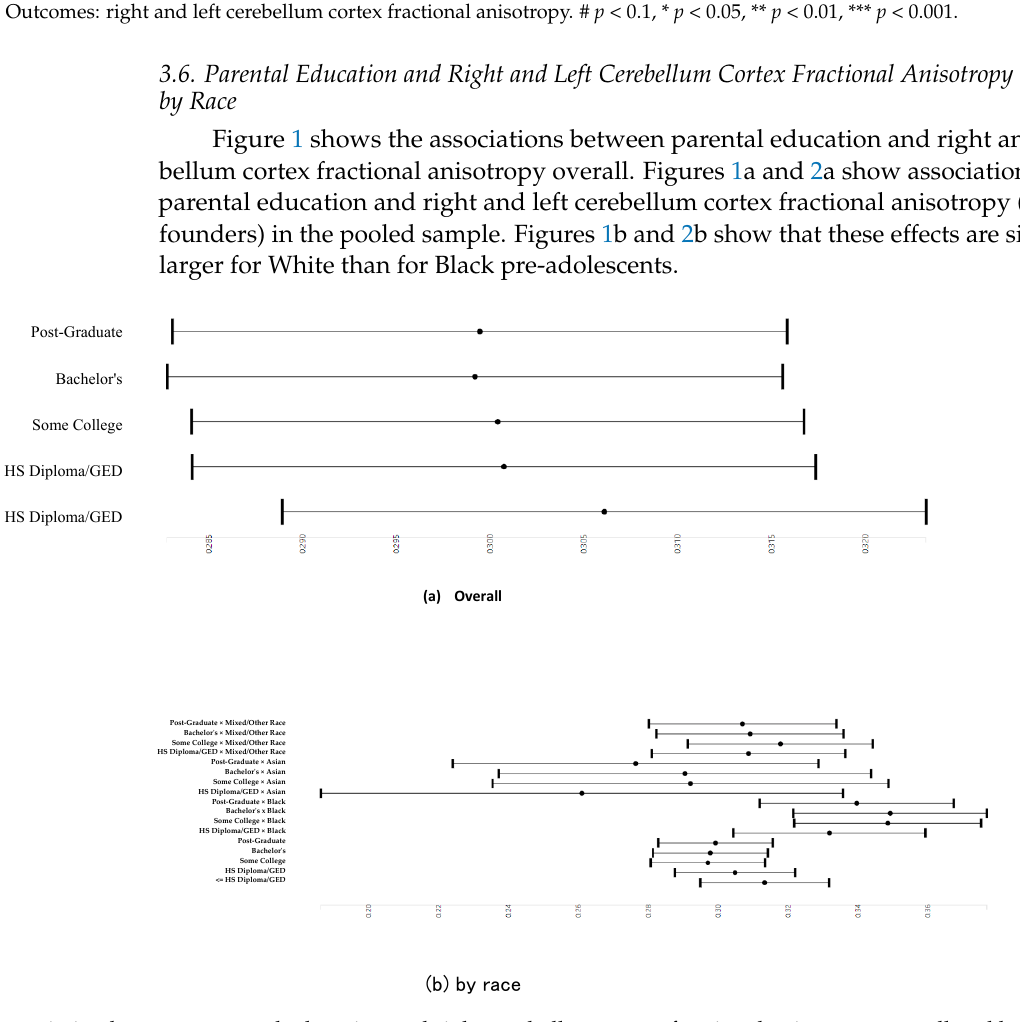
Figure 1. Association between parental education and right cerebellum cortex fractional anisotropy overall and by